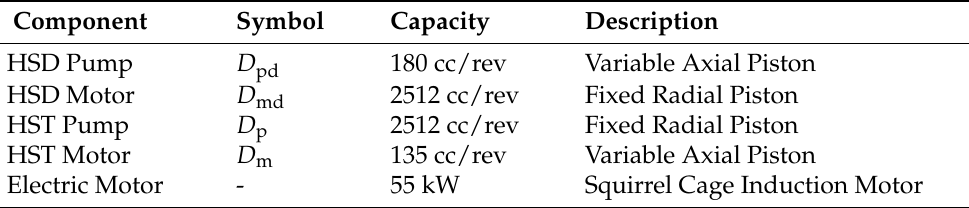
Table 1. Key components of the power-regenerative test